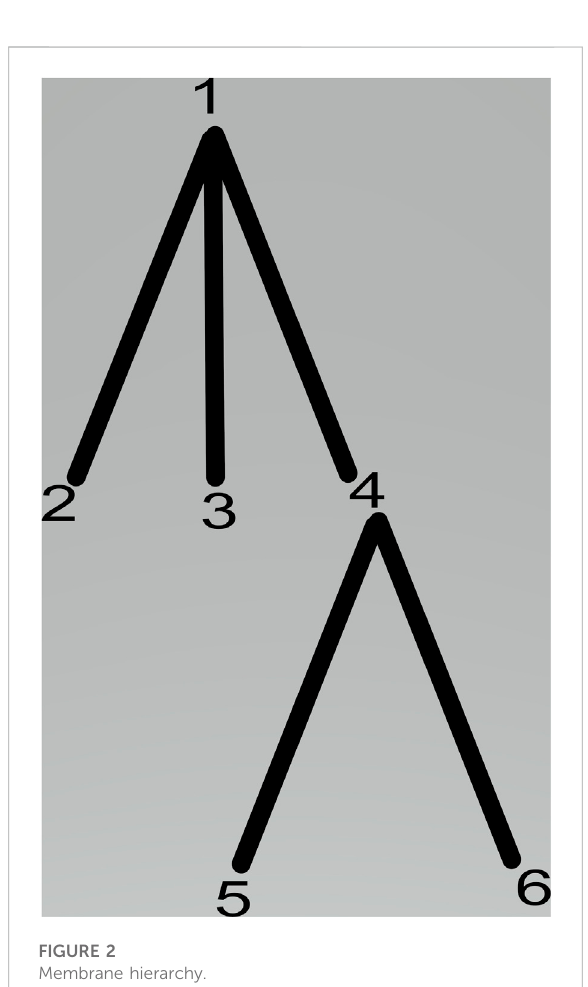
FIGURE 2 Membrane